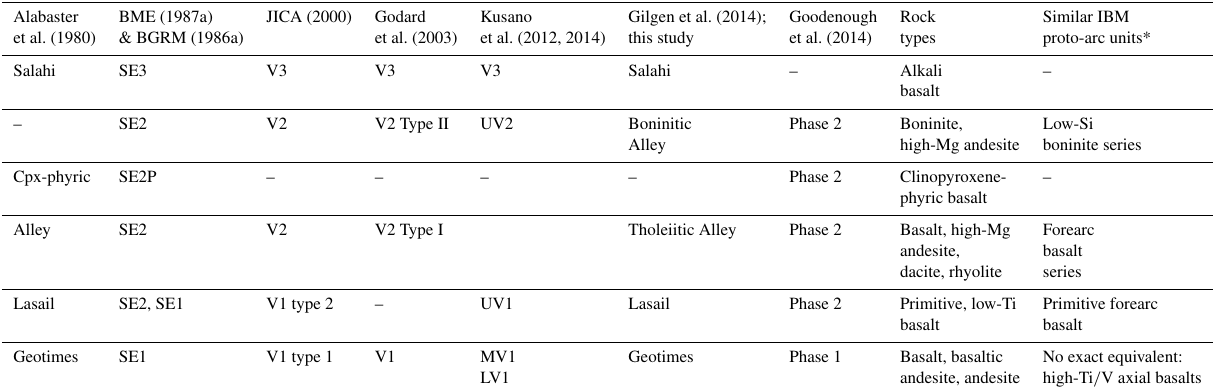
Table 1. Comparison of different naming schemes for the Semail volcanostratigraphy and the closest-equivalent rock types identified in the Izu–Bonin–Mariana (IBM) proto-arc record.